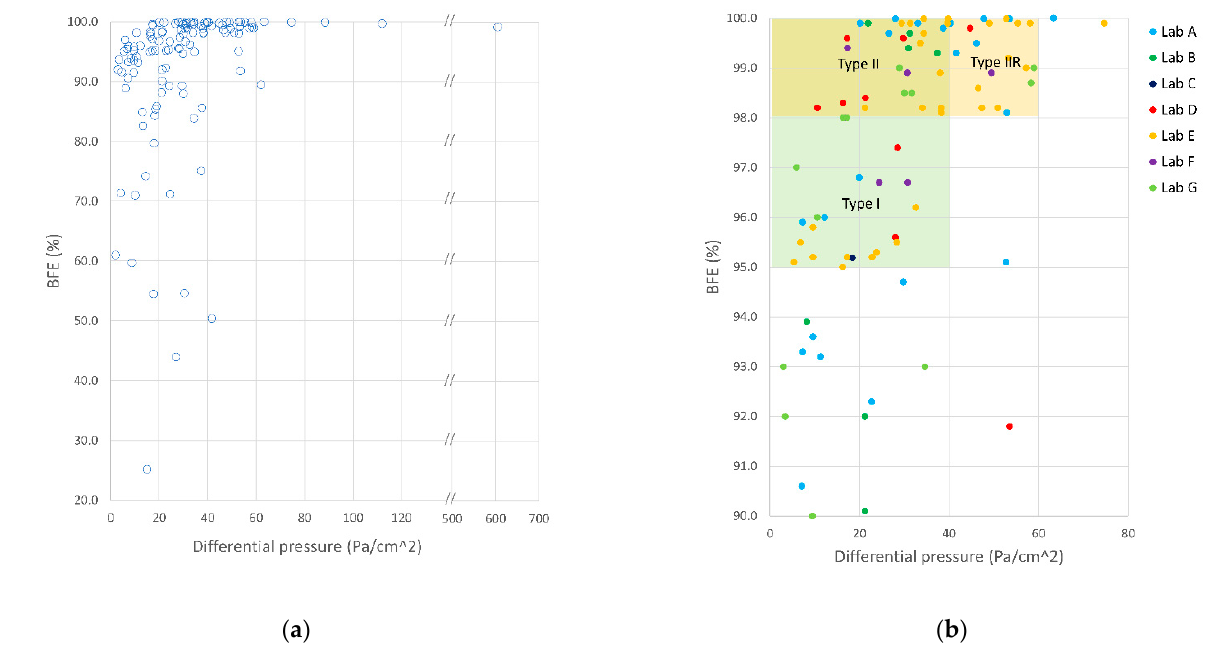
Figure 8. Bacterial filtration efficiency (BFE) vs. breathability (DP). All collected data are presented in the left graph ( a ). The right graph ( b ) presents a subset of data closer to the highest performance. Ranges of performance required by EN 14683:2019+AC are indicated for Type I, Type II and Type IIR masks. Data are color-coded by laboratory.